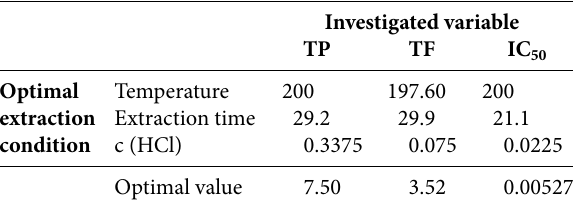
Table 6 . Optimized extraction conditions for maximized yields of TP and TF and minimized IC 50